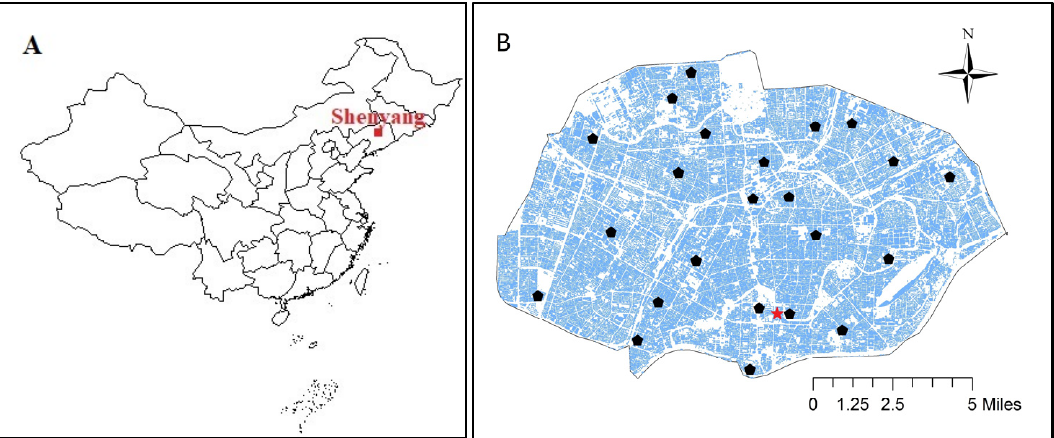
Figure 1. Geographical location of Shenyang in China ( A ) and the fixed observation site (red star) and 23 sampling sites (black points) investigated in Shenyang ( B ).